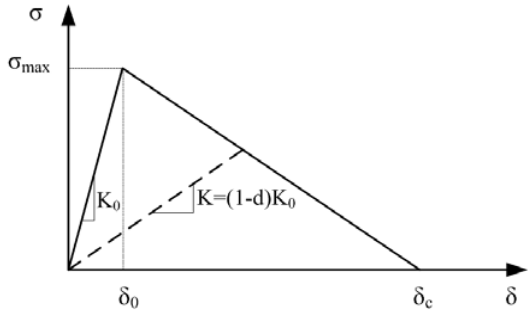
Figura 2: Legame tensioni-apertura per il modello di zona